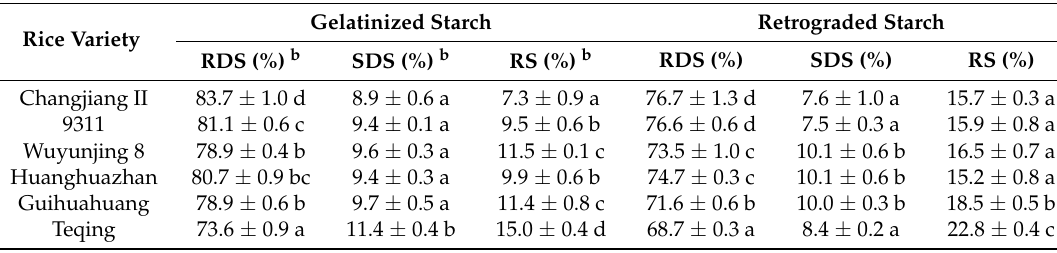
Table 6. Digestion properties of gelatinized and retrograded starches a .